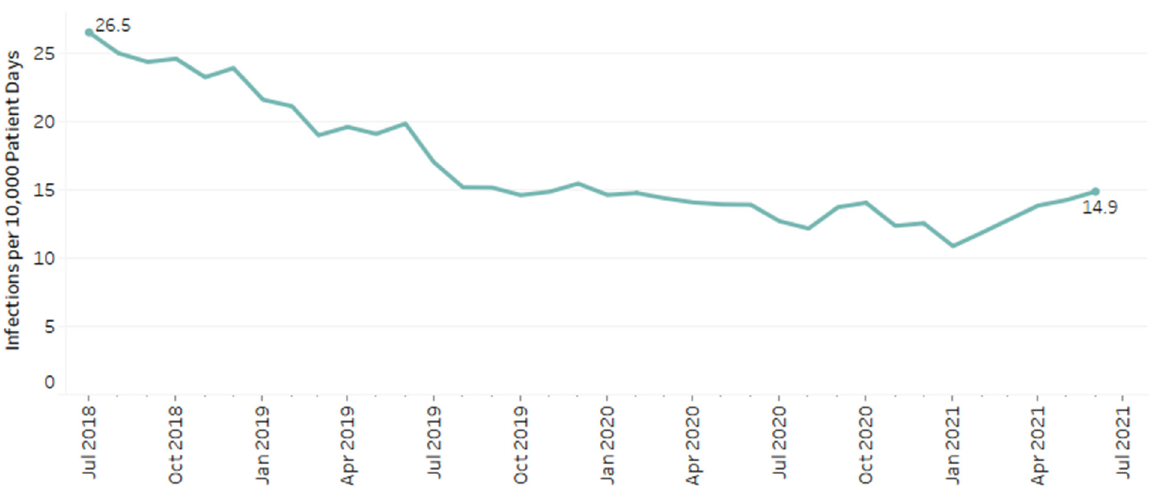
Figure 2. C. difficile rates among patients with cephalosporin and fluoroquinolone use. Resistance to ceftriaxone, cefepime, ciprofloxacin and levofloxacin in E. coli, extended spectrum beta-lactamase (ESBL)- producing E. coli and P. aeruginosa are shown in Figure 3. From 2018 to 2021, E. coli ’s resistance to cefepime and ceftriaxone remained consistent at 3% and 4%, respectively. Resistance to ciprofloxacin and levofloxacin decreased from 22% and 21% to 21% and 19%, respectively, by 2021 ( p < 0.001; p < 0.001). For ESBL E. coli isolates, resistance to ciprofloxacin and levofloxacin remained stable from 2018 to 2020 at 82% and 80%, respectively. From 2020 to 2021, ESBL E. coli ’s resistance to fluoroquinolones decreased to 79% and 77% ( p < 0.001; p < 0.001). Resistance patterns for P. aeruginosa did not show any significant changes during the study period for any of the medications included. Resistance among P. aeruginosa isolates from 2018 to 2021 to cefepime, ciprofloxacin and levofloxacin was 5–6%, 12–13% and 14–15%, respectively.